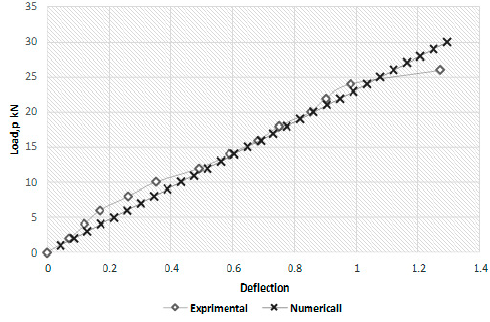
Figure 23. Load–deflection diagram of beam (B1).